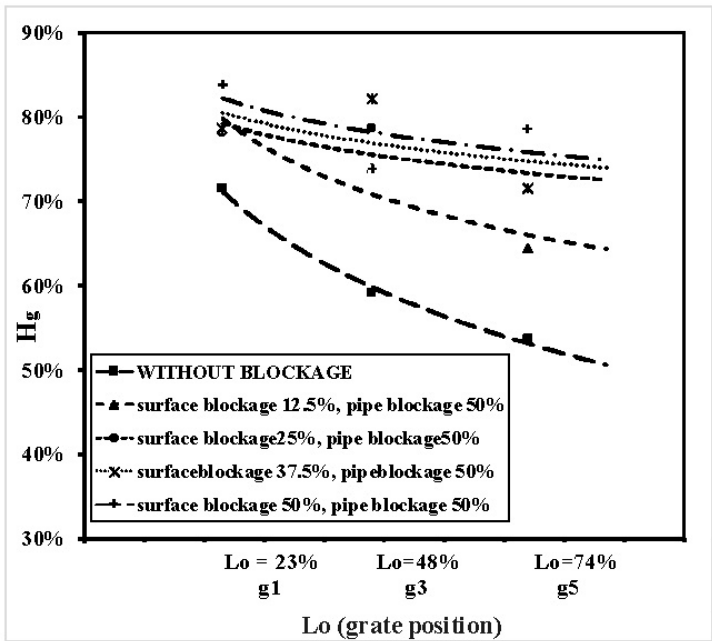
28 Figure 28. Relationship between Hg and LO for di 25% at Q = 6.00 L / sec.